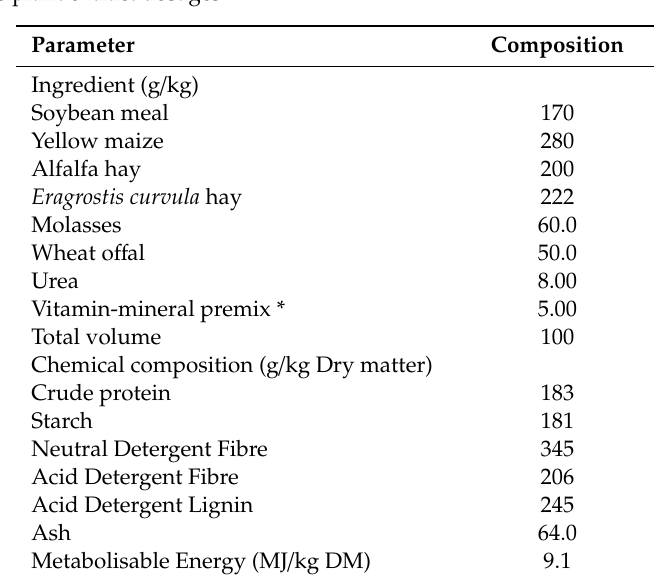
Table 1. Composition and chemical analysis of total mixed ration fed to SA Mutton Merino sheep receiving various plant extract